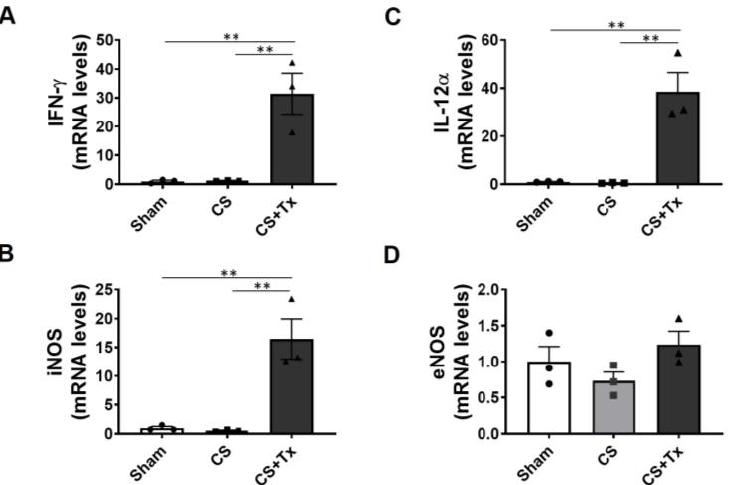
Figure 4. Cold storage plus transplantation induces inflammatory cytokine and nitric-oxide synthase genes. Quantitative real-time PCR (SYBR Green) was performed with rat renal mRNA extracts (as in previous figures) to assay expression of ( A ) IFN- γ, ( B ), IL- 12α, ( C ) inducible nitric-oxide synthase (iNOS), and ( D ) epithelial nitric-oxide synthase (eNOS). Data are the mean ± SEM (bars, n = 3). 1-way ANOVA followed by Brown–Forsythe and Welch’s corrections for multiple group comparisons were used for analysis; p < 0.05 was considered significant for Sham vs. CS + Tx and CS vs. CS + Tx groups. **, p < 0.01. Each solid circle, square, or triangle represent individual animals within the group.